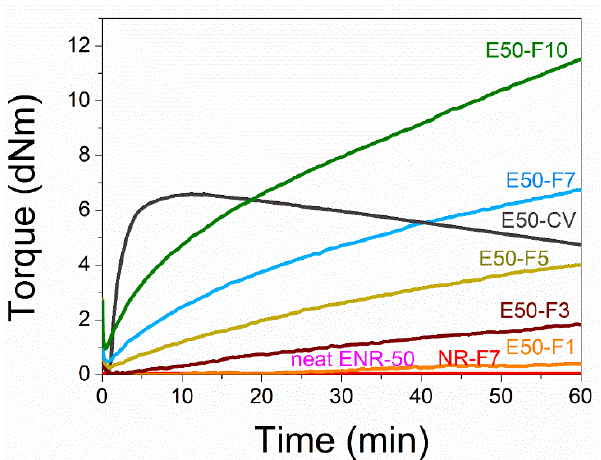
Figure 1. Mixing torque-time curves of ENR-50 compounds with various concentrations of FeCl 3 at 1, 3, 5, 7 and 10 mmol (i.e., E50-F1, E50-F3, E50-F5, E50-F7 and E50-F10, respectively), and the conventional sulfur vulcanization (i.e., E50-CV), neat ENR-50, and unmodified NR (ADS) with 7 mmol of FeCl 3 (NR-F7). Table 3. Cure characteristics in terms of minimum torque (M L ), maximum torque (M H ), torque dif- ference (M H -M L ), scorch time (T s2 ) and cure time (T c90 ) of various ENR-50 compounds.